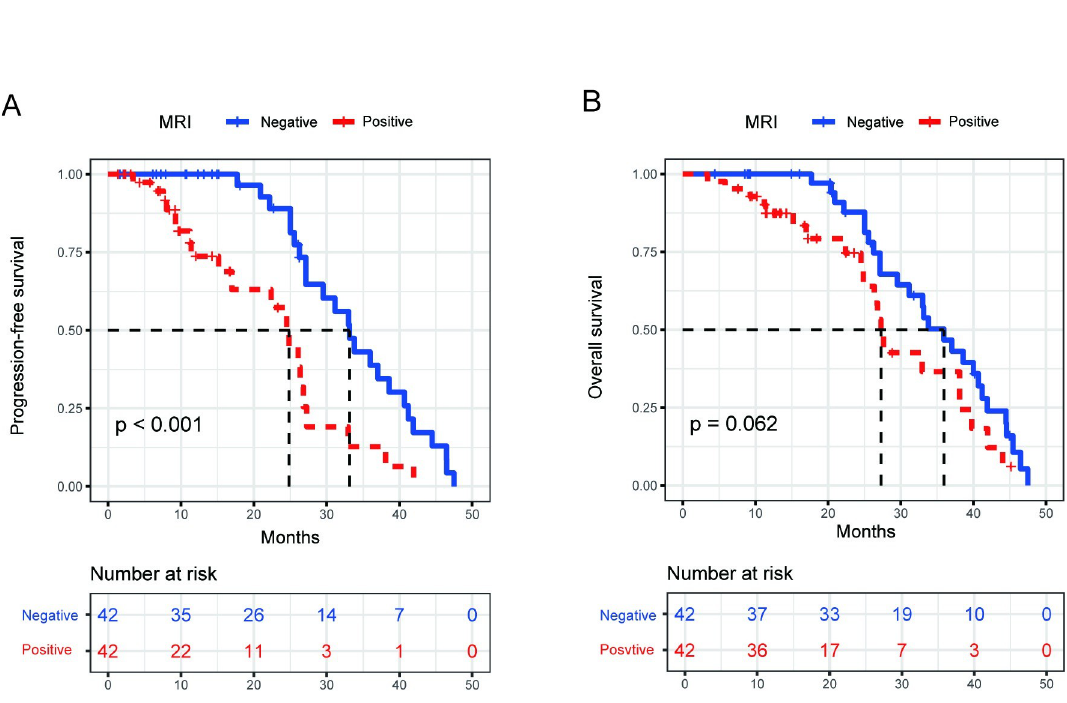
Fig 9. Survival curves of patients diagnosed using pelvic magnetic resonance imaging after propensity score matching. (A): Progression-free survival curve. (B): Overall survival curve.